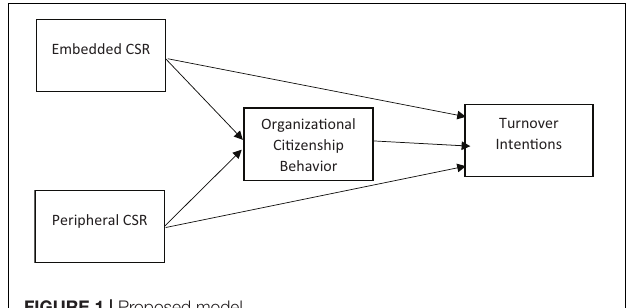
FIGURE 1 | Proposed